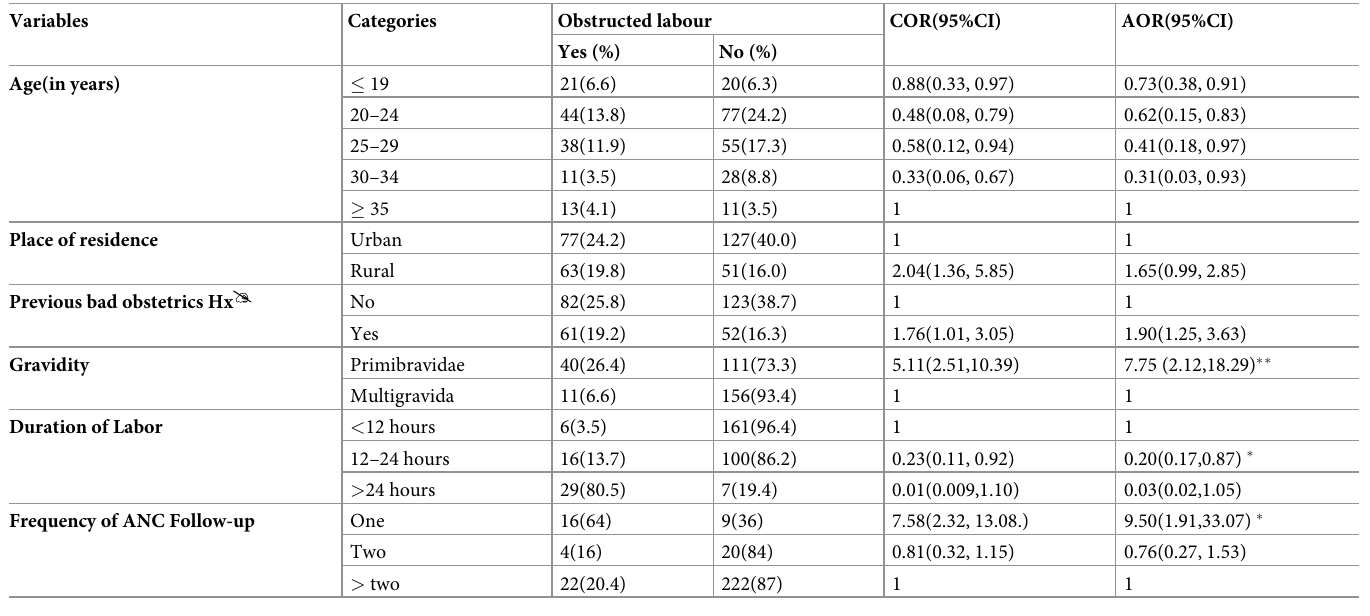
Table 4. Factors associated with obstructed labour among women gave birth at public health facilities in Mojo town, Central Ethiopia, 2019 (n = 318).